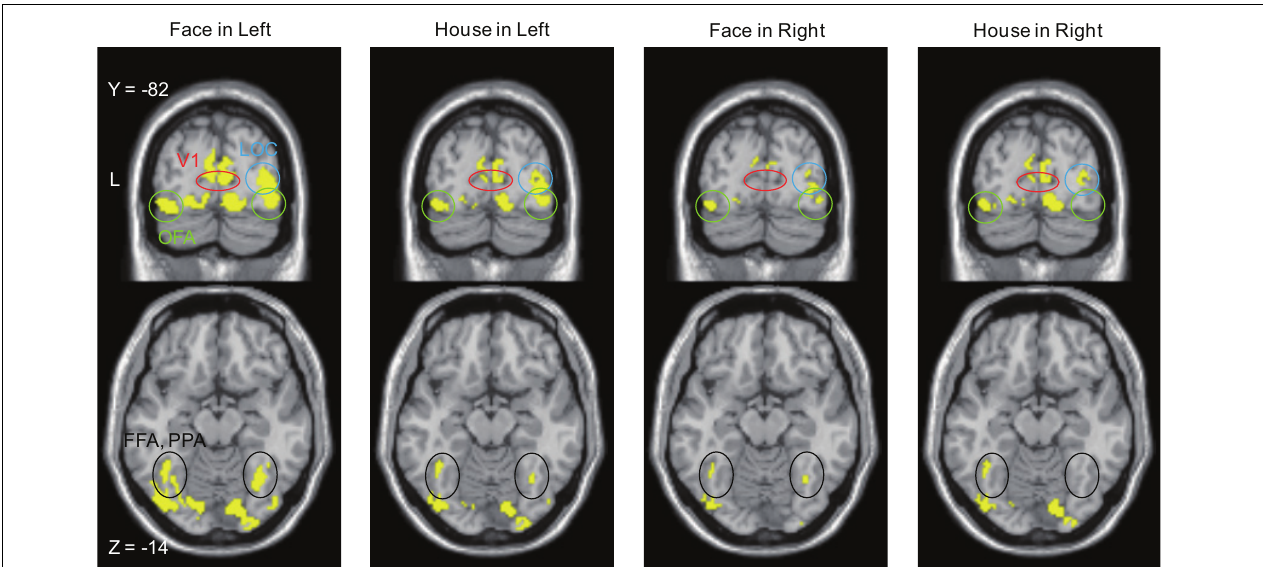
FIGURE 7 | Brain areas in which sources were estimated at time bins between 20 and 50ms after stimulus onset. The display threshold is at peak level P (unc.) < 0.001. Red circle, V1 (striate cortex); Green circle,